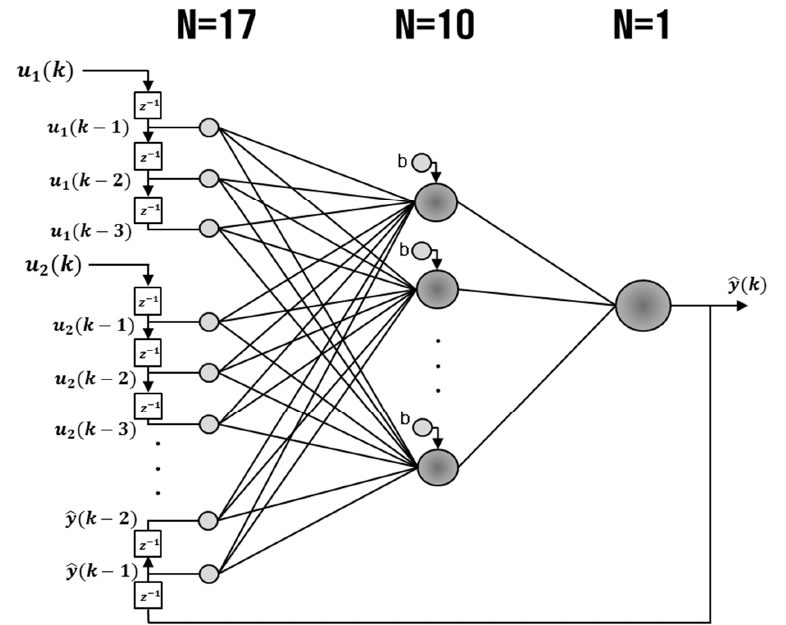
Figure 5. NARX Neural network model for estimation of vehicle state parameters (z − 1 is the unit time delay).